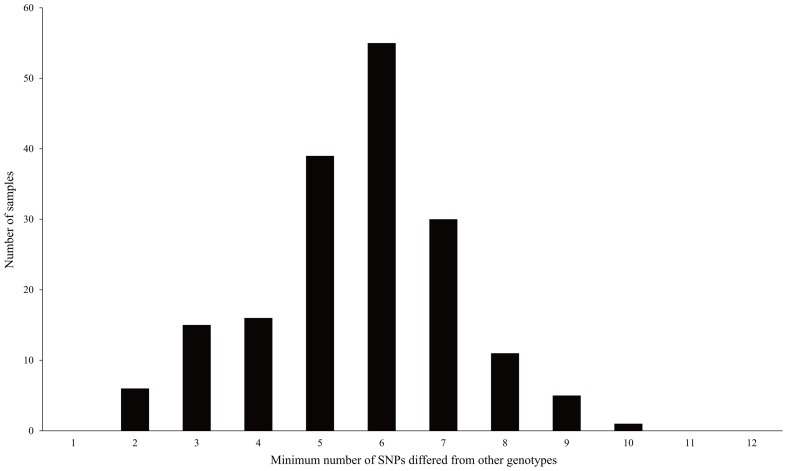
Distribution of the minimum number of SNPs differed between a genotype and other genotypes.